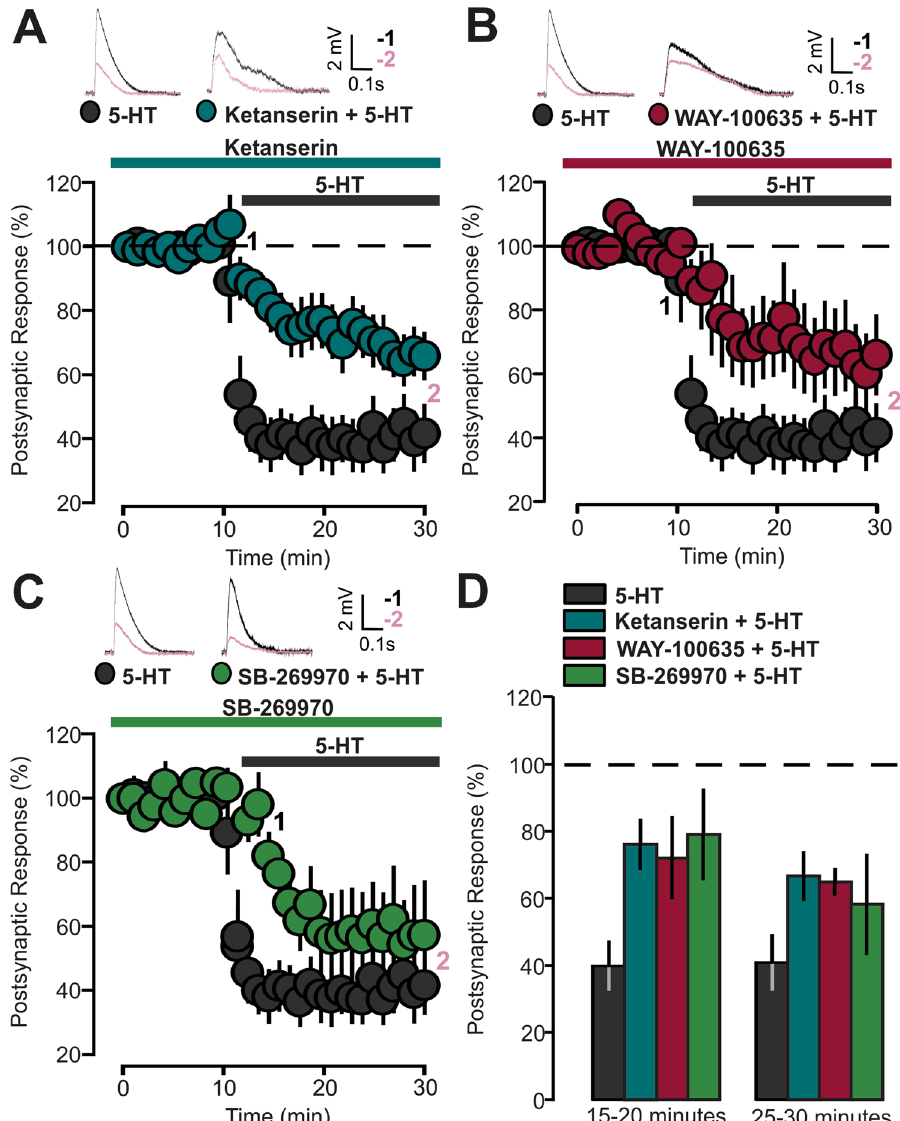
Figure 2. 5-HT 2A , 5-HT 1A , and 5-HT 7 receptors antagonists inhibit the effects of 5-HT on synaptic transmission. ( A ) The graph shows the EPSPs recorded in P14-16 animals before and during 5-HT (50 µM) bath application, in the presence or not of the 5-HT 2A receptor antagonist. Two different conditions are compared: 5-HT (dark grey inserts, 5-HT, 50 µM) and 5-HT 2A receptor antagonist + 5-HT (blue inserts; Ketanserin, 10 µM, + 5-HT, 50 µM). The EPSPs were normalized to the mean of responses recorded during the baseline and the bars represent the SEM. Traces show the results of a representative experiment with the average of postsynaptic responses recorded before (1: 5 to 10 min, black line) and after (2: 25 to 30 min, magenta line) application of 5-HT. ( B ) The graph shows the EPSPs recorded in P14-16 animals before and after 5-HT (50 µM) application in the presence or not of 5-HT 1A receptor antagonist. Two different conditions are compared: 5-HT (dark grey inserts, 5-HT) and 5-HT 1A receptor antagonist + 5-HT (red inserts, WAY-100635, 1 µM, + 5-HT, 50 µM). The EPSPs were normalized to the mean of responses recorded during the baseline and the bars indicate the SEM. Traces show the results of a representative experiment with the average of postsynaptic responses recorded before (1: 5 to 10 min, black line) and after (2: 25 to 30 min, magenta line) application of 5-HT. ( C ) The graph shows the EPSPs recorded in P14-16 animals before and after 5-HT (50 µM) application, with two different conditions being compared: 5-HT (dark gray inserts, 5-HT) and 5-HT 7 receptor antagonist + 5-HT (green inserts, SB-269970, 10 µM, + 5-HT, 50 µM). The EPSPs were normalized to the mean of responses recorded during the baseline and the bars represent the SEM. Traces show the results of a representative experiment with the average of postsynaptic responses recorded before (1: 5 to 10 min, black line) and after (2: 25 to 30 min, magenta line) application of 5-HT. ( D ) Summary of the depressive effects of 5-HT. The graph bars show the EPSP values recorded during two different periods of the experiment: 15–20 min and 25–30